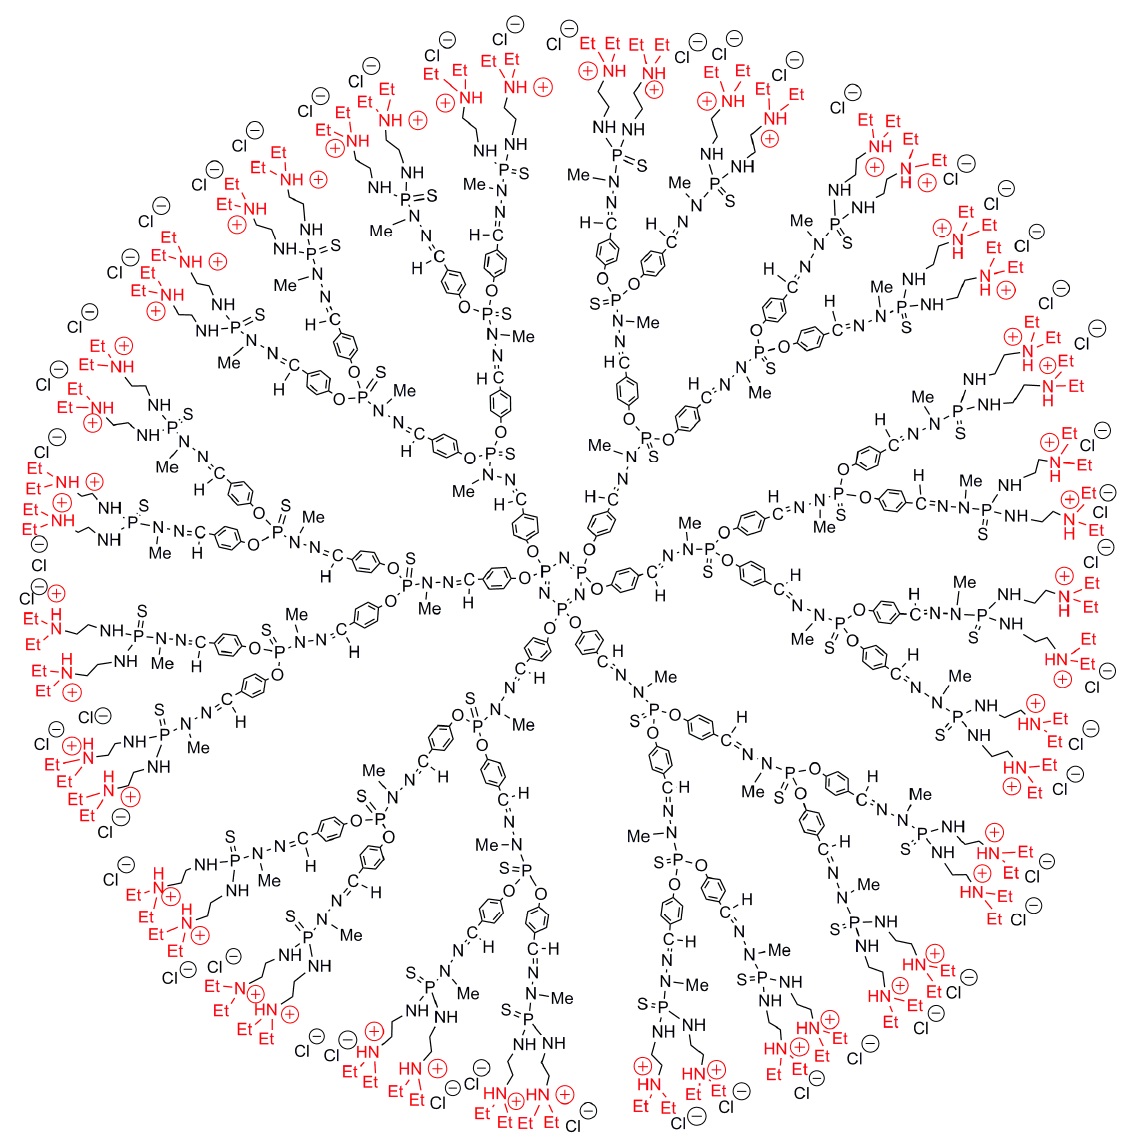
Figure 2. Water-soluble third-generation phosphorus dendrimer with 48 tertiary ammonium terminal Water-soluble third-generation phosphorus dendrimer with 48 tertiary functions.